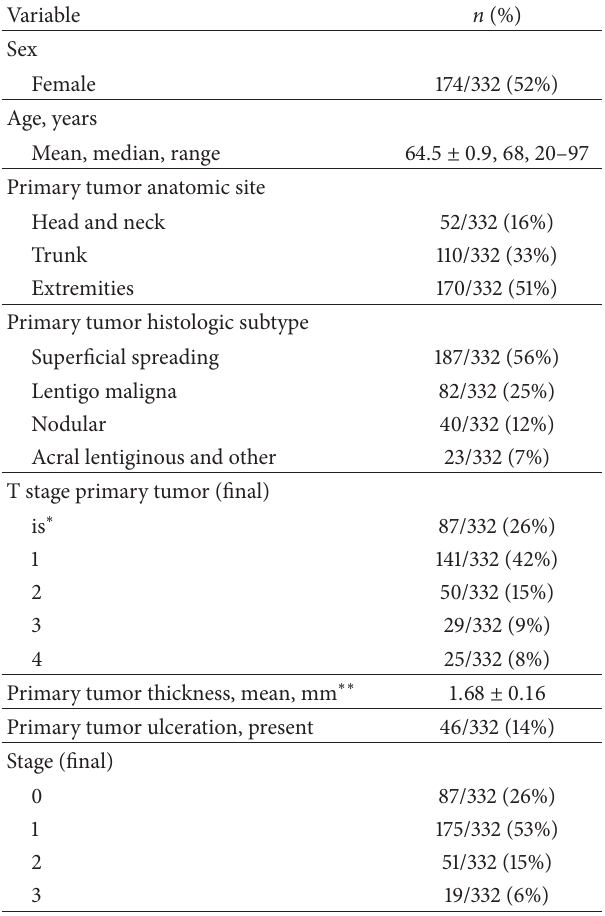
Figure 1. Among the 121 patients with residual melanoma identified in the WLE specimen, the Breslow depth was less than or equal to the biopsy depth in 68 cases (56%), while tumor thickness increased in 53 cases (44%) and tumor level increased in 26 cases (21%). T-stage reclassification occurred